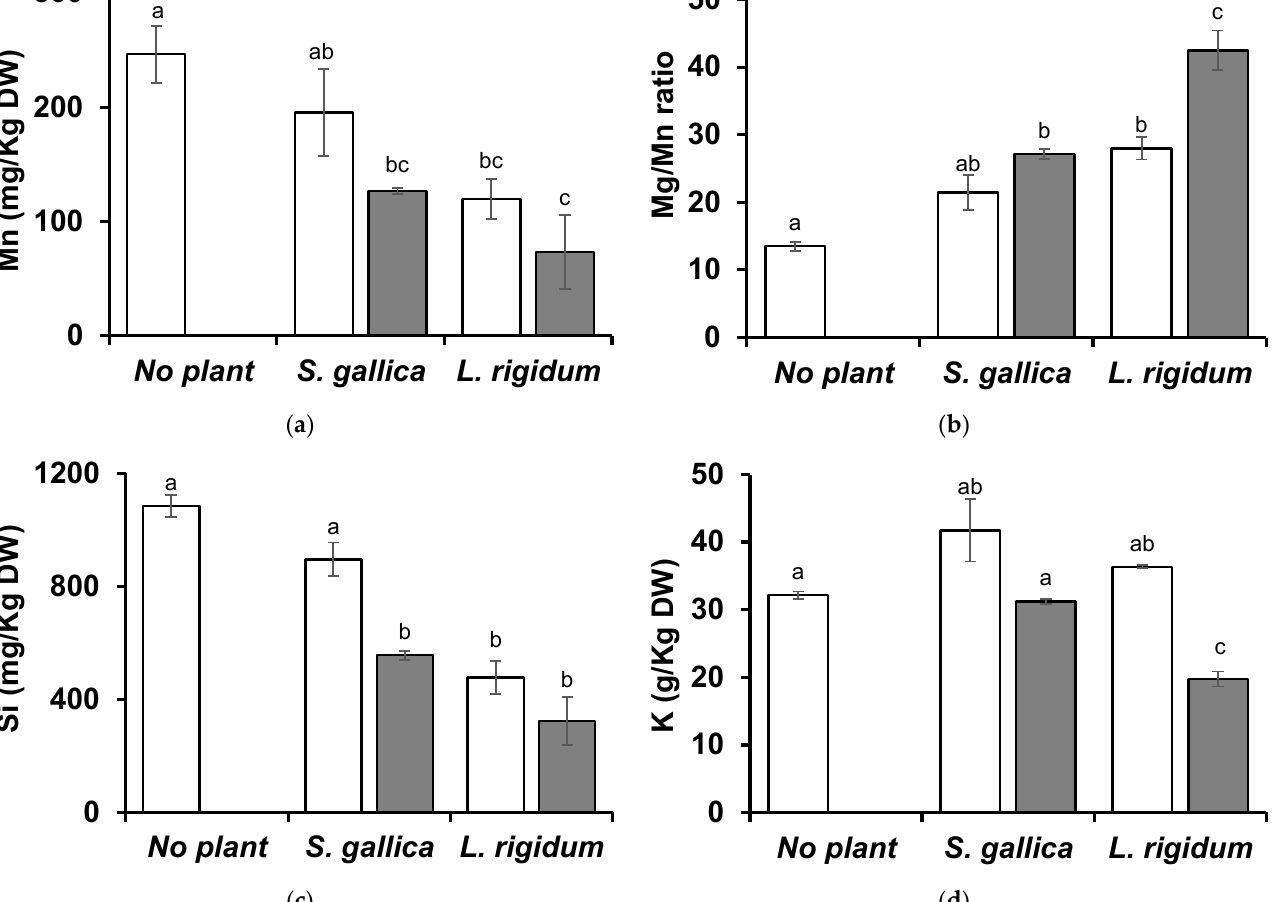
Figure 3. Concentration of Mn ( a ), Si ( c ), K ( d ) and Mg/Mn ratio ( b ) in shoots of 3-week-old wheat grown in disturbed (white columns) and undisturbed (grey columns) acidic soil with arbuscular mycorrhizal fungi associated with previously grown Silene gallica L. (non-mycotrophic) and Lolium rigidum L. (strongly mycotrophic) and with no prior developer, under Mn toxic conditions. Different letters indicate statistically significant differences between the different treatments ( p < 0.05).